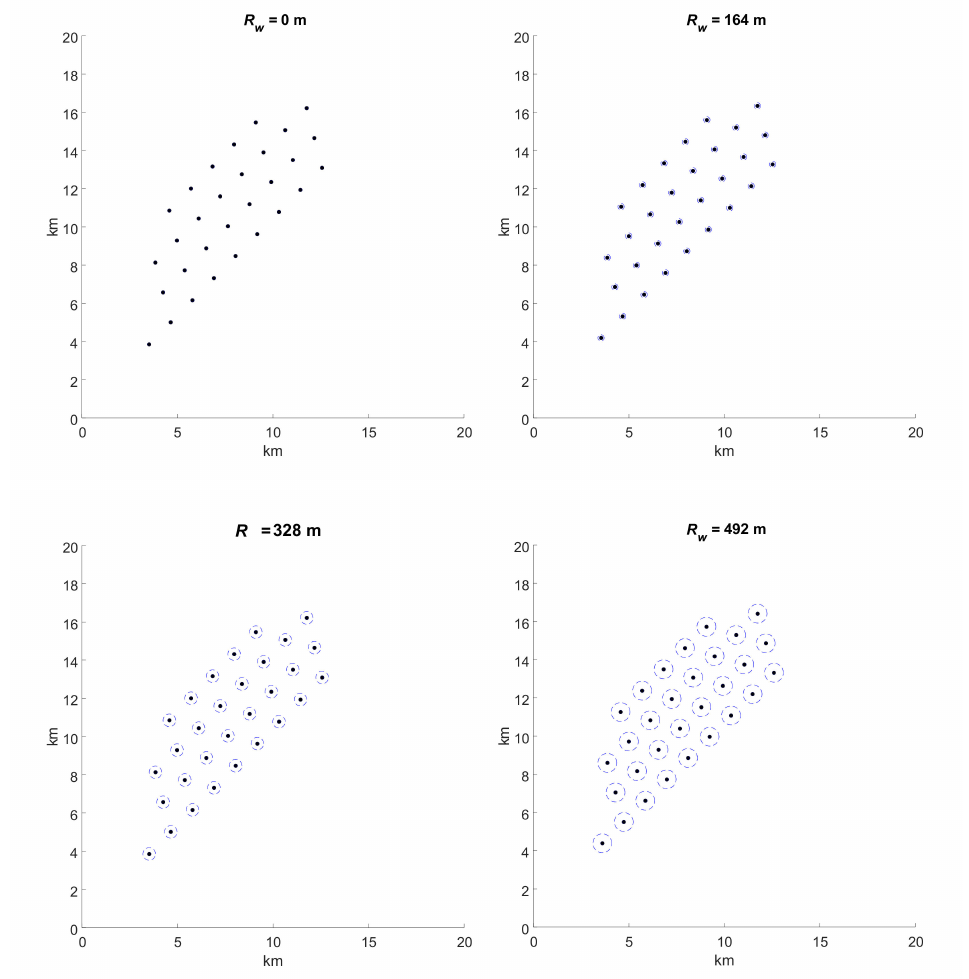
Figure 6. Optimal layouts obtained for the different R w analysed in Case